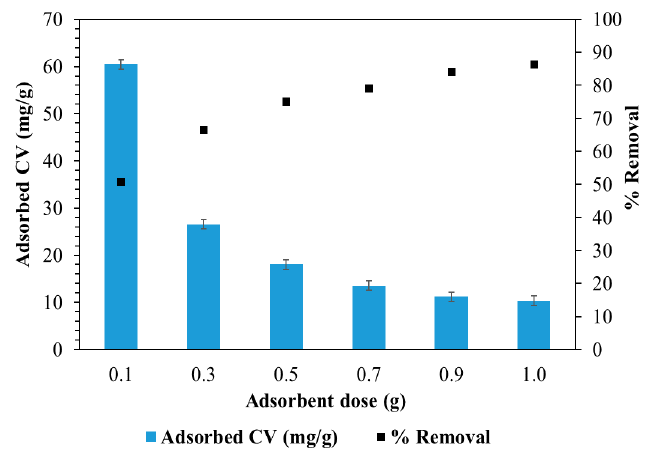
Figure 4. E ff ect of BC-PKS dosage (0.1–1.0 g) on the adsorbed CV per unit mass of BC-PKS (mg / g) Figure 4. Effect of BC-PKS dosage (0.1–1.0 g) on the adsorbed CV per unit mass of BC-PKS (mg/g) and and the removal percentage of CV by BC-PKS (%) (initial concentration: 400 mg / L; volume: 30 mL; the removal percentage of CV by BC-PKS (%) (initial concentration: 400 mg/L; volume: 30 mL; adsorbent dosage: 0.1–1.0 g; reaction time: 24 h; temperature: 25 ◦ C). adsorbent dosage: 0.1–1.0 g; reaction time: 24 h; temperature: 25 ° C).